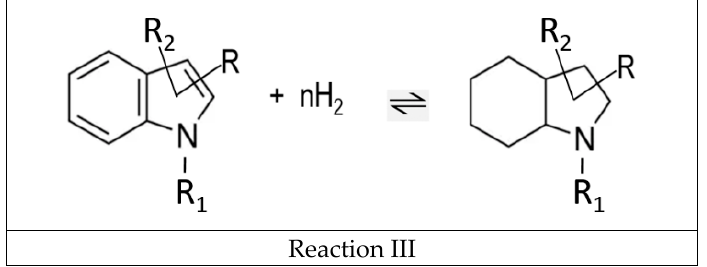
Figure 6. Reversible reactions of the full hydrogenation of the indole derivatives.